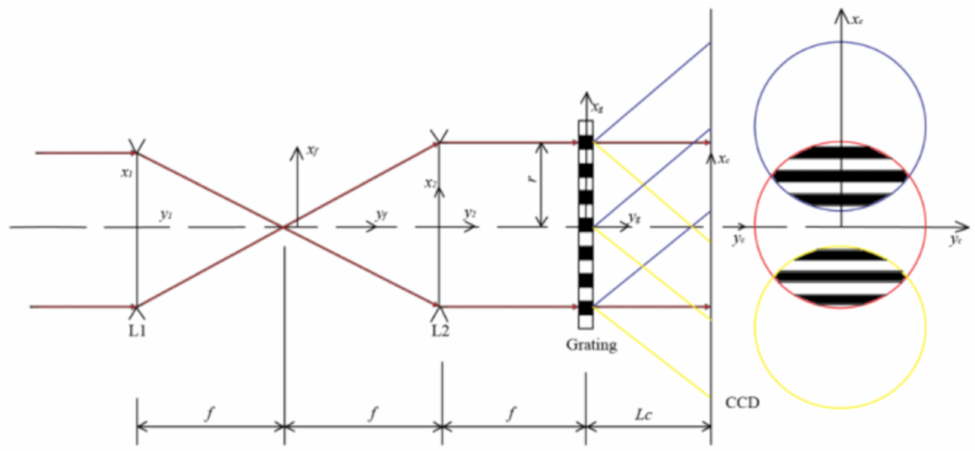
Figure 2. Illustration of grating di ff ractive